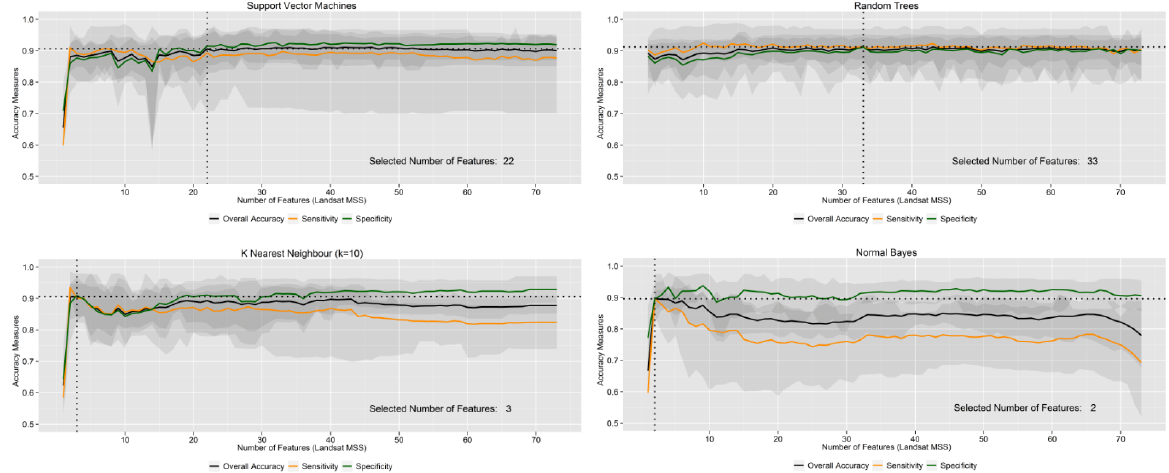
Figure 6. Influence of the size of the feature vector on the classification accuracy for MSS. Mean and range of accuracy measures from the ten-fold cross-validation are shown for each iteration.